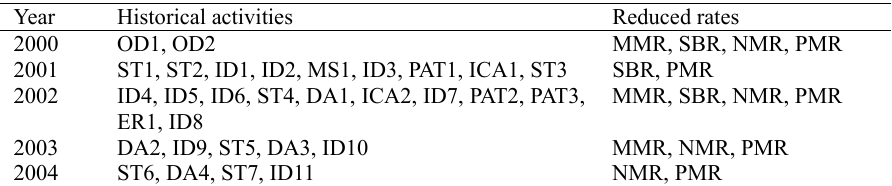
Table 2. Linking CSHW’s service outcome with its history of TQM implementation